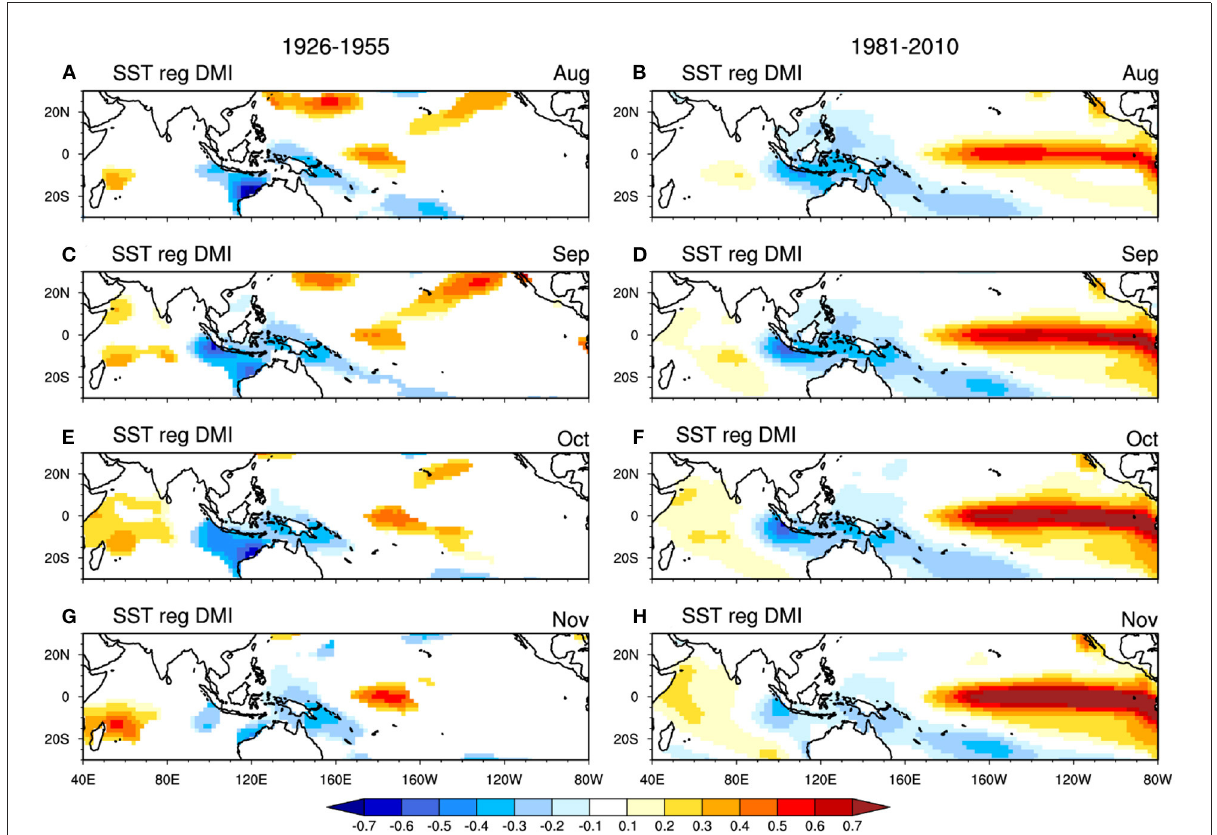
FIGURE2 Regressions of monthly SSTA (unit: ◦ C) onto the standardized SON-mean DMI index for the observation in the period 1926–1955: (A) August, (C) September, (E) October, and (G) November. Only values reaching the 5% significance level are shown. Right: (B, D, F, H) as in (A, C, E, G) , but for the period